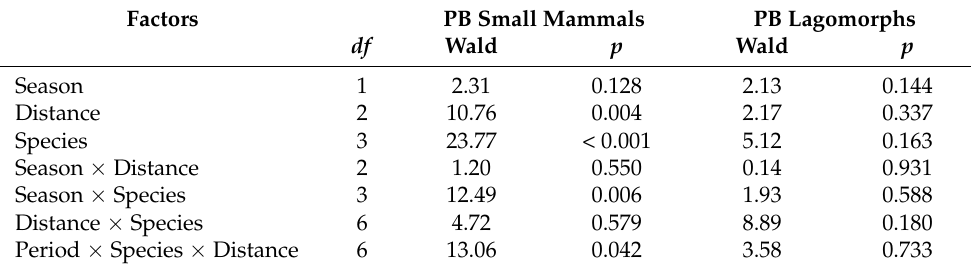
Table 3. Factors determining the percentage of fresh biomass ( PB ) of the main trophic resources (small mammals and lagomorphs) present in the analyzed scats. Results of the GLM using PBs of small mammals and lagomorphs as response variables. The variables were arcsine square root transformed for